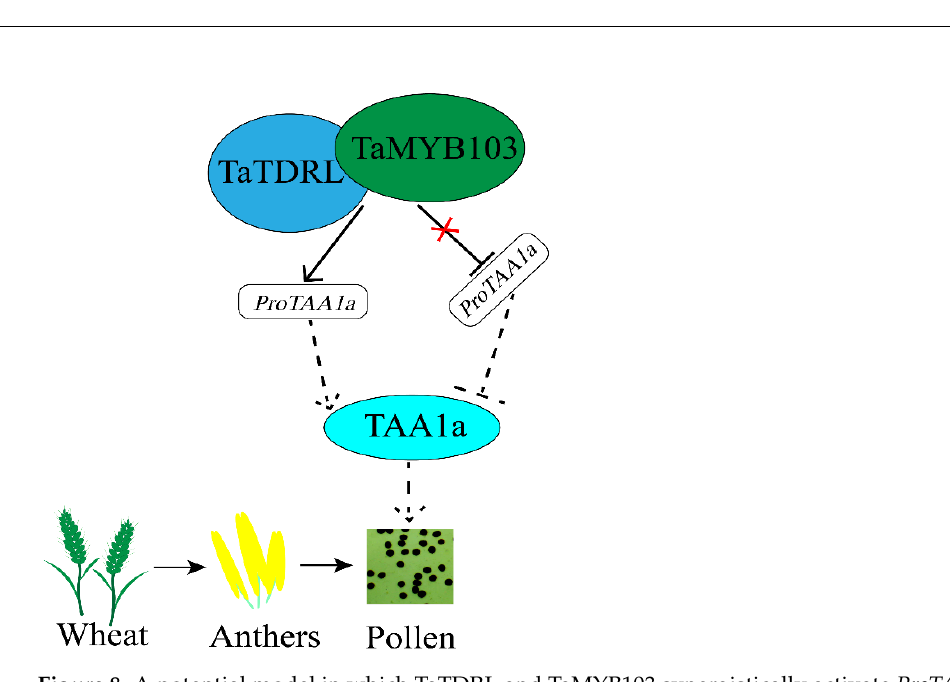
Figure 8. A potential model in which TaTDRL and TaMYB103 synergistically activate ProTAA1a to regulate wheat pollen development.